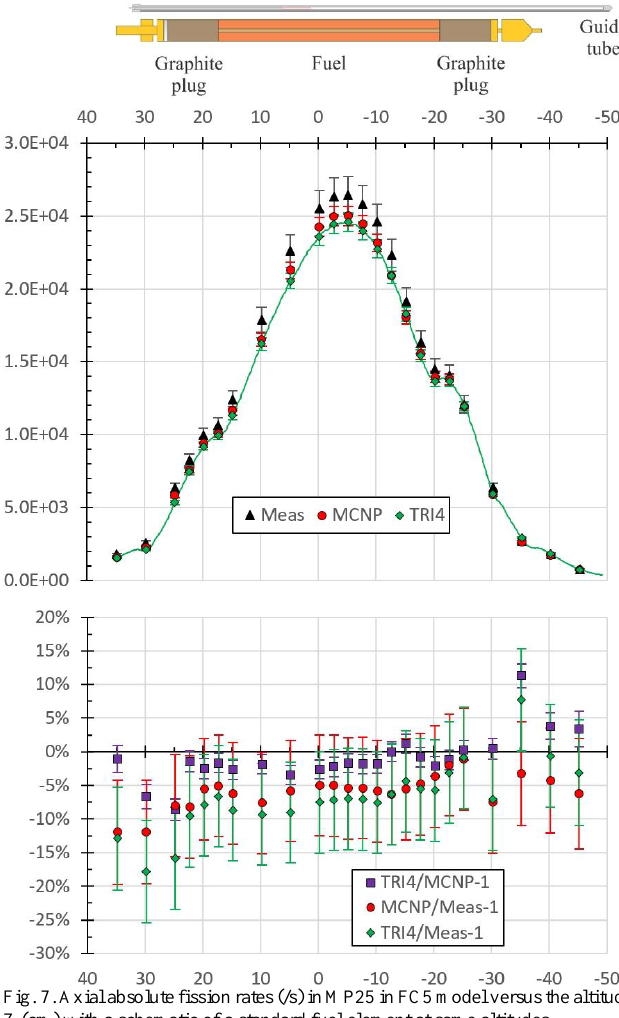
Fig. 7. Axial absolute fission rates (/s) in MP25 in FC5 model versus the altitude Z (cm) with a schematic of a standard fuel element at same